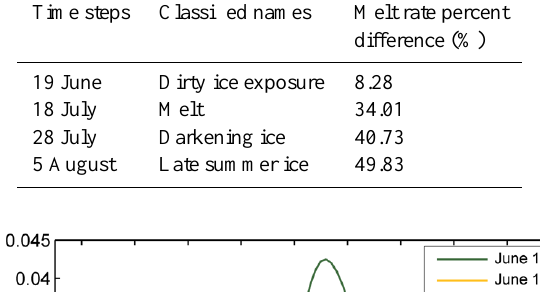
Table 4. Percent difference in melt rate estimates for different albedo probability density functions and averaged incoming solar radiation conditions at Base Met Station from 16, 19, and 25 June relative to “early summer ice” (1 June) distribution.